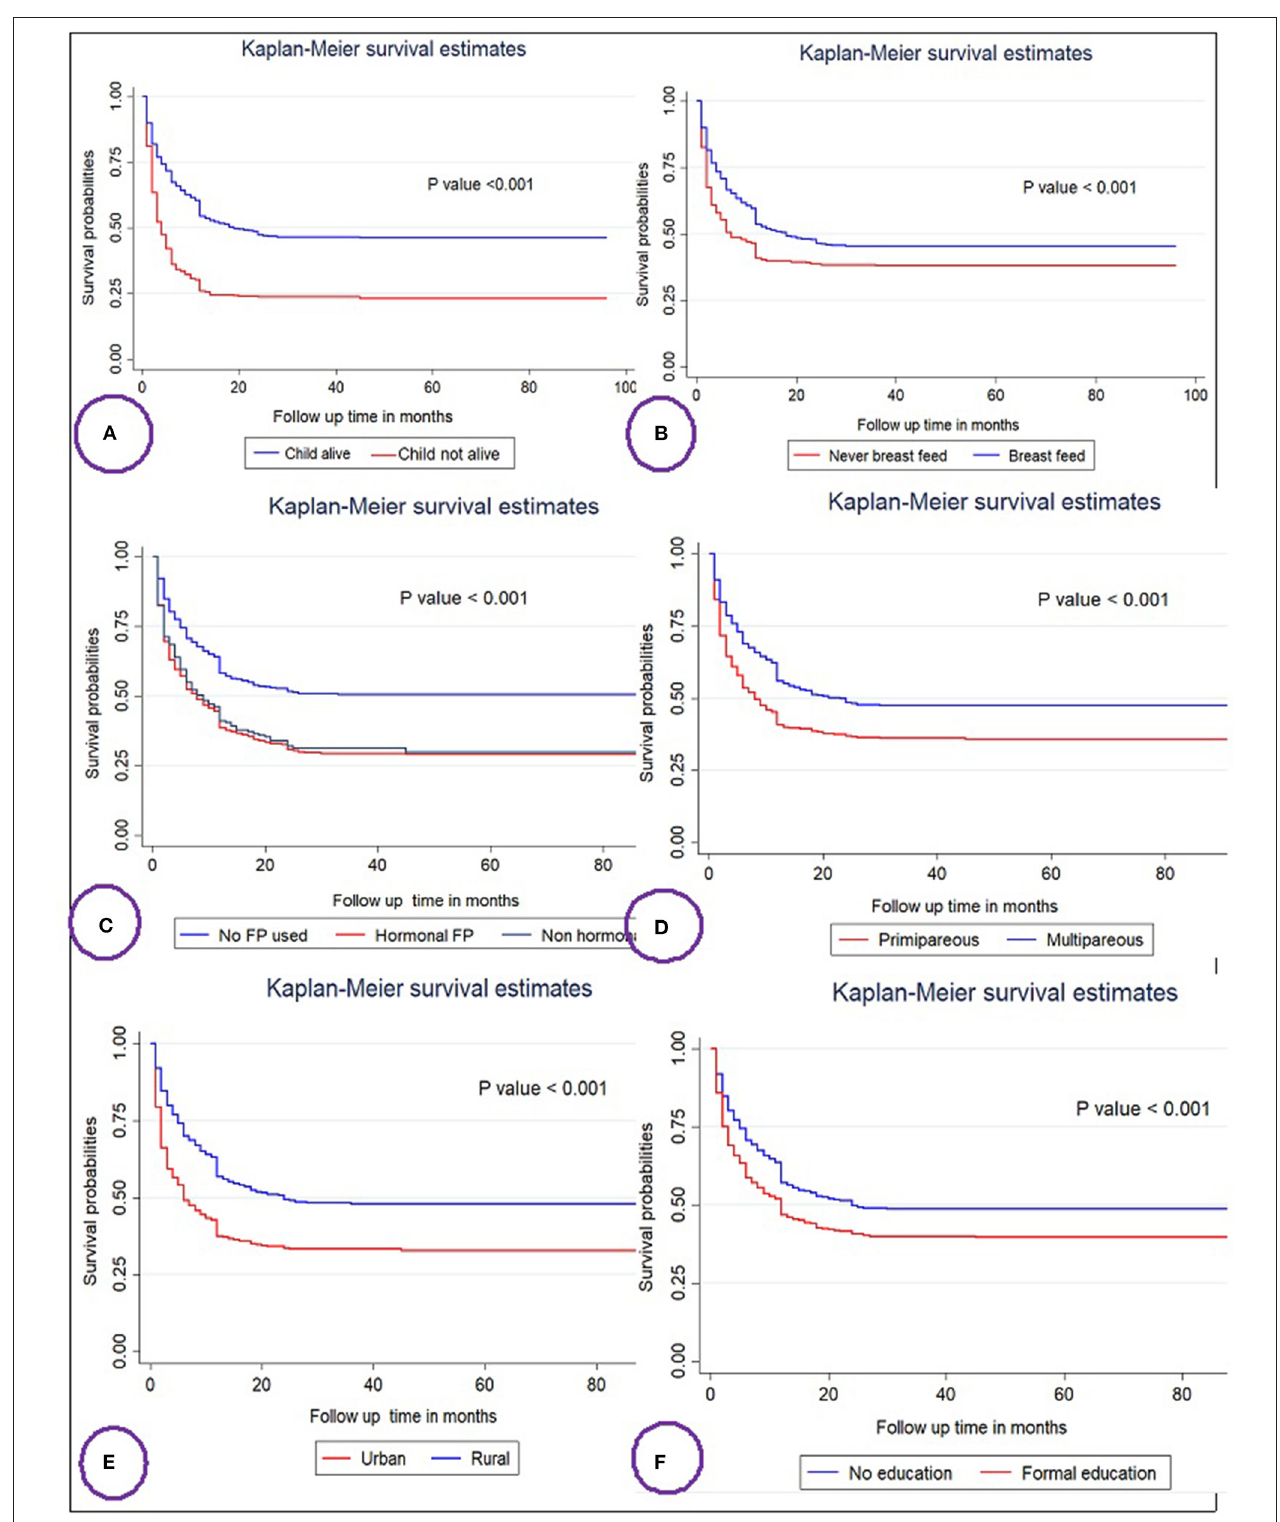
FIGURE 1 | Kaplan–Meier survival curves and log rank tests of the time to resumption of postpartum menses among women’s in Ethiopia based on child status (A) , breast feeding (B) , family planning (FP) usage (C) , parity (D) , residence (E) , and educational status (F) .